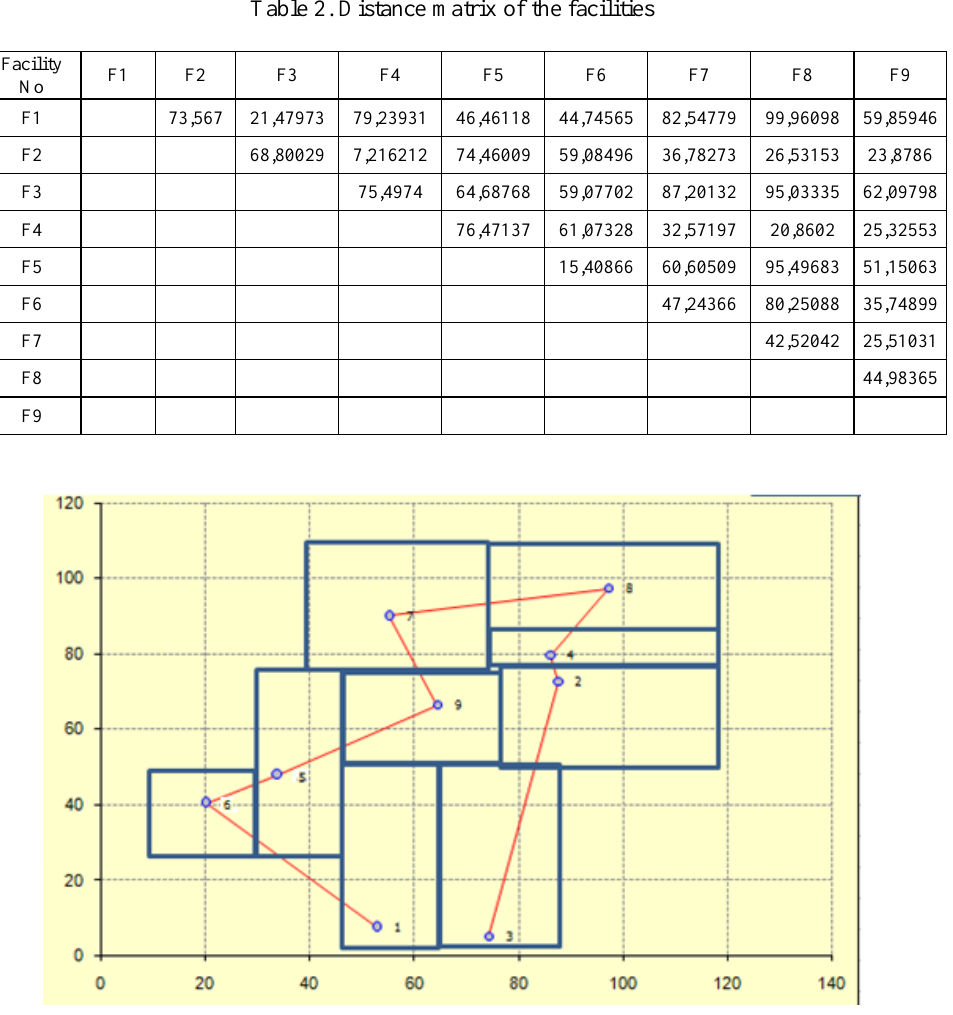
Table 2. Distance matrix of the facilities